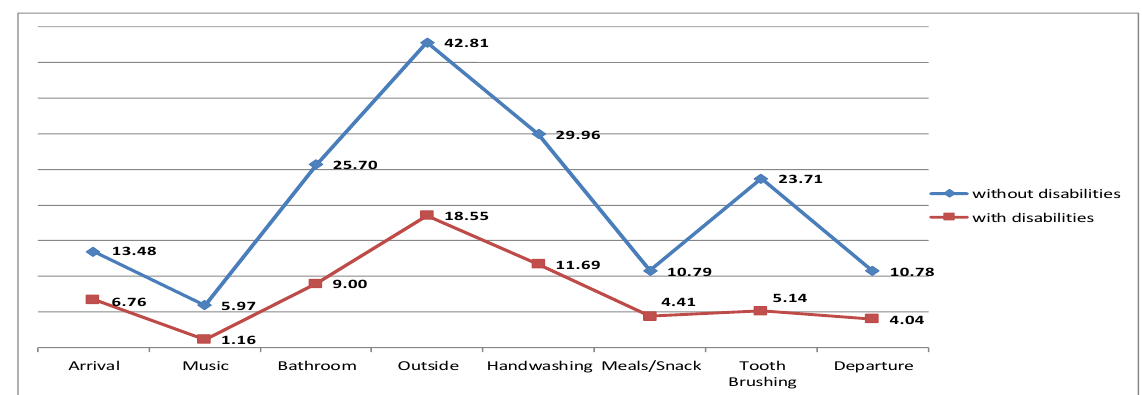
Figure 2. SR = social relationships.